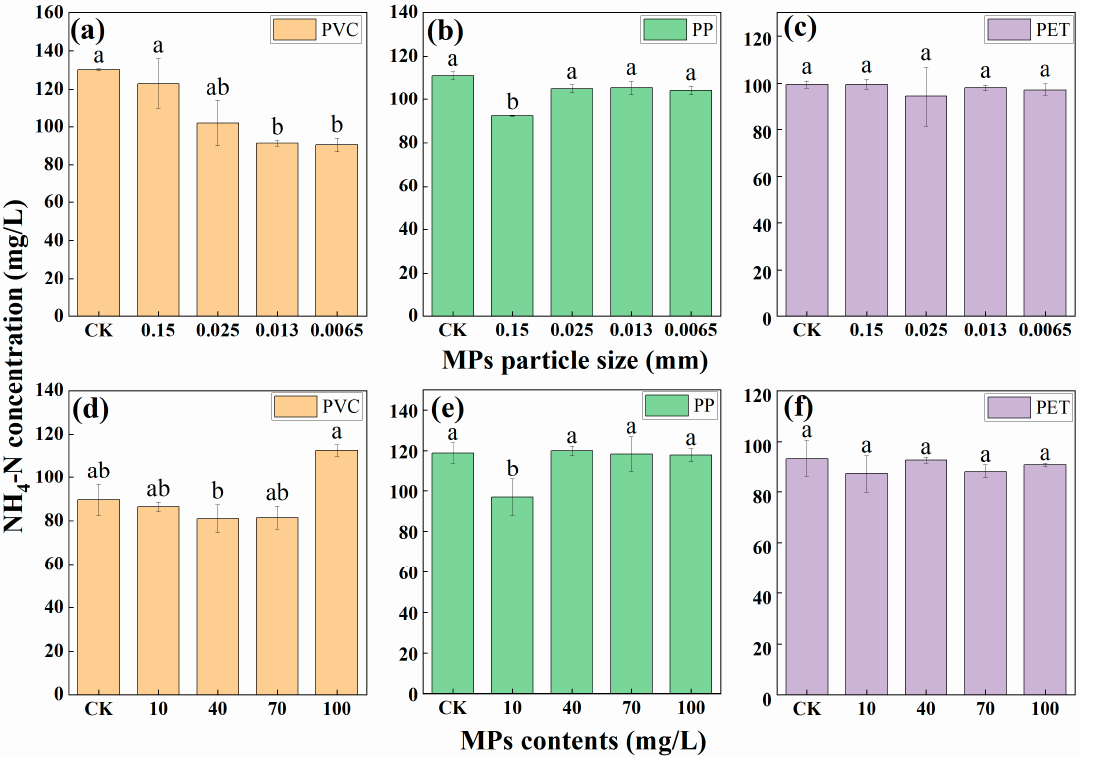
Figure 2. NH 4 ‐ N concentration in wastewater treated by MPs with different particle sizes ( a – c ) and contents ( d – f ). Different letters above the error bars indicate statistically significant differences ( p < 0.05).